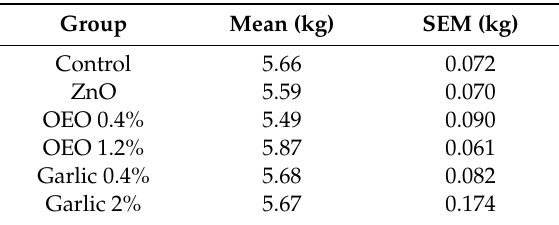
Table 4. Bodyweight at the beginning of the trial 1